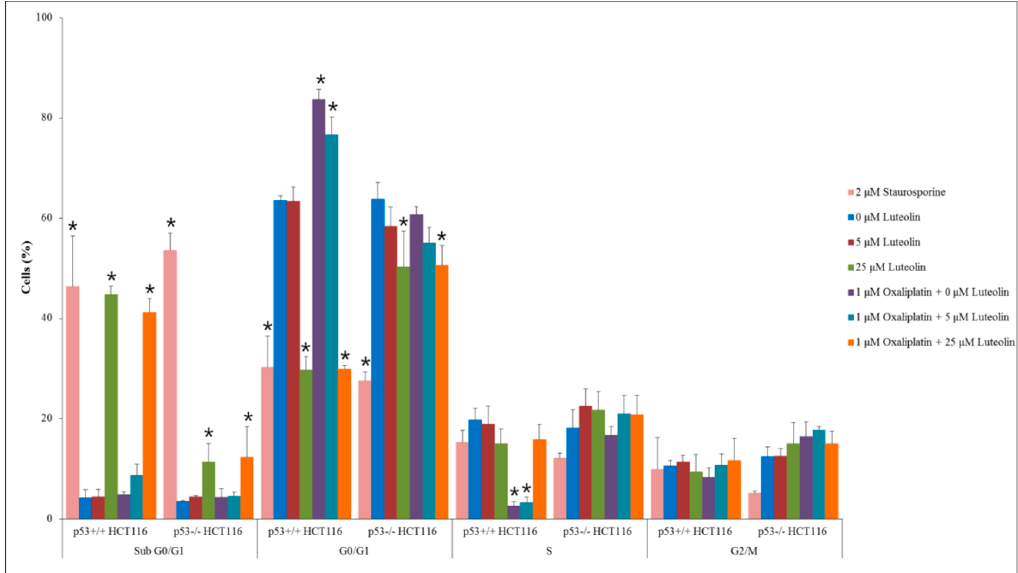
Figure 3. Cell cycle analysis in p53 +/+ and p53 -/- HCT116 cells. Cells were seeded in a 100-mm dish and treated with 5 or 25 μ M of luteolin in the absence or presence of 1 μ M oxaliplatin for 24 h. Staurosporine (2 μ M) was used as a positive control to induce apoptosis. Data are expressed as mean ± SD of three independent experiments (*, a significant difference compared to the control group at p < 0.05).